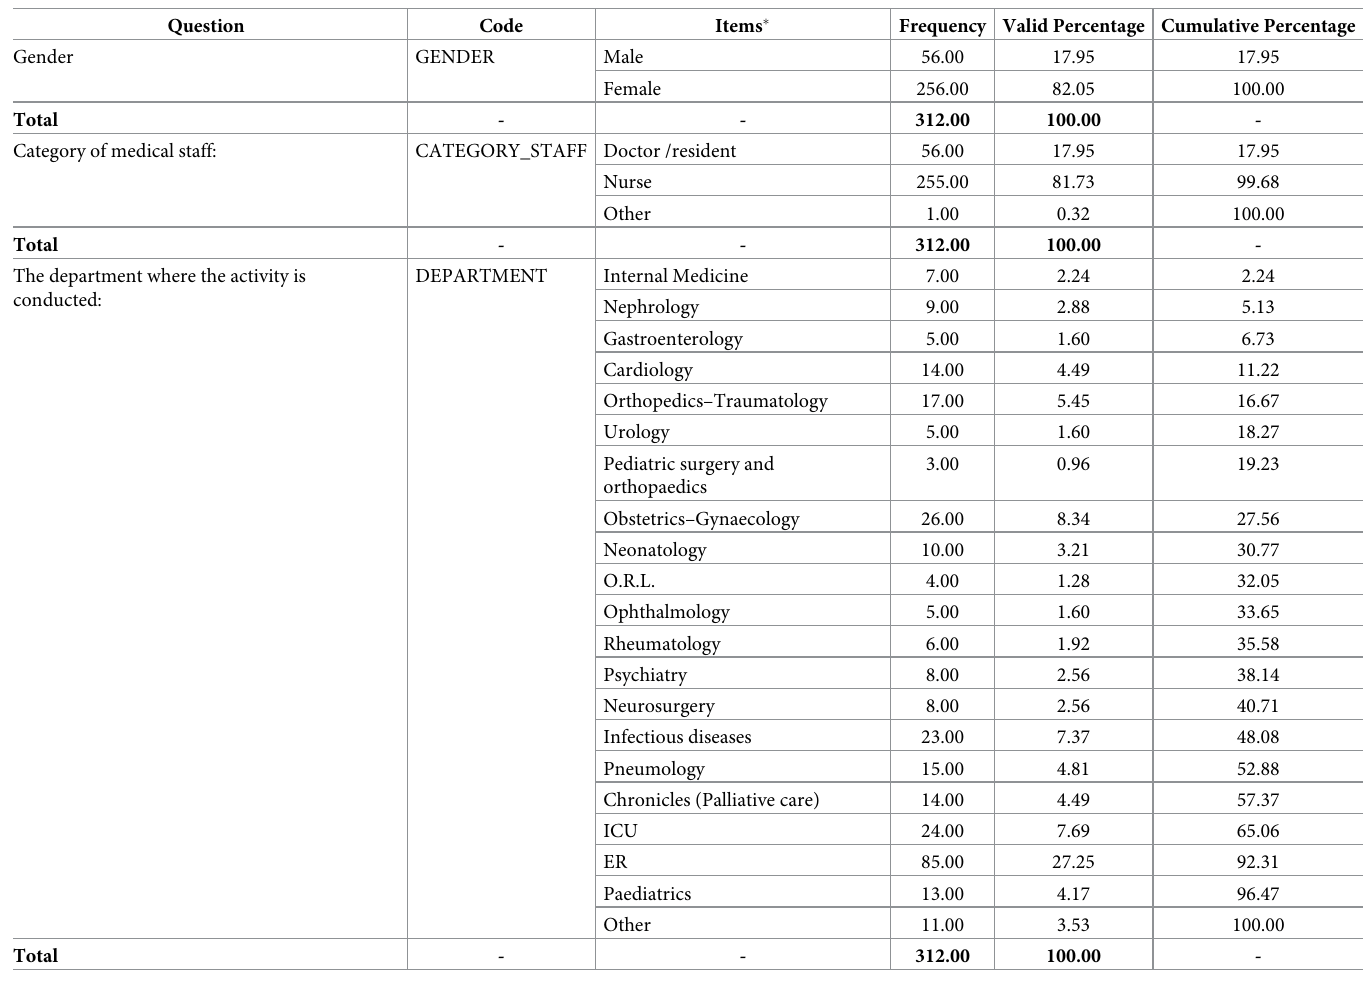
Table 1. Items and results clarifying research methodology (N =